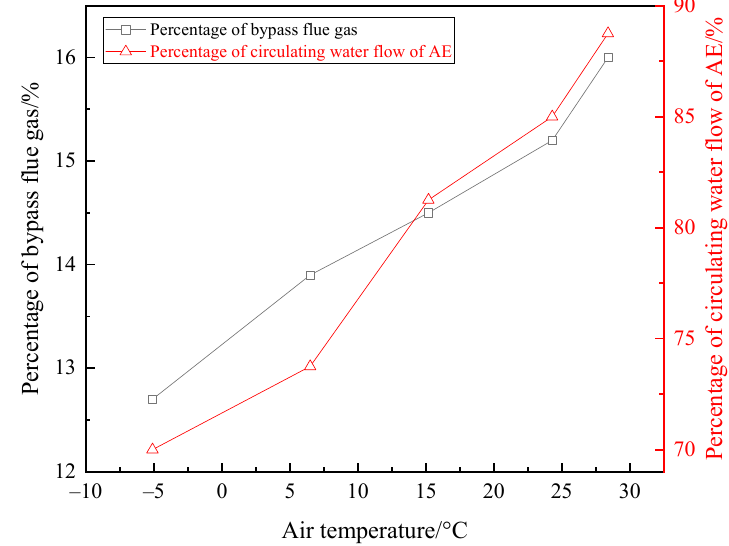
Figure 16. Adjustment curve as air temperature changed .